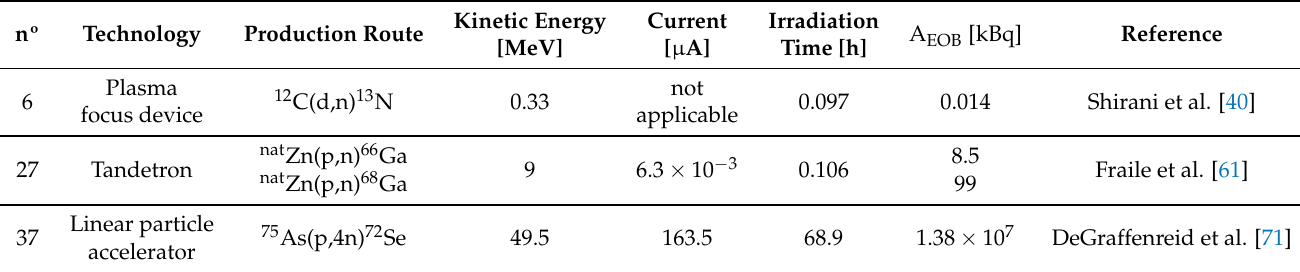
Table A4. Other technologies produced